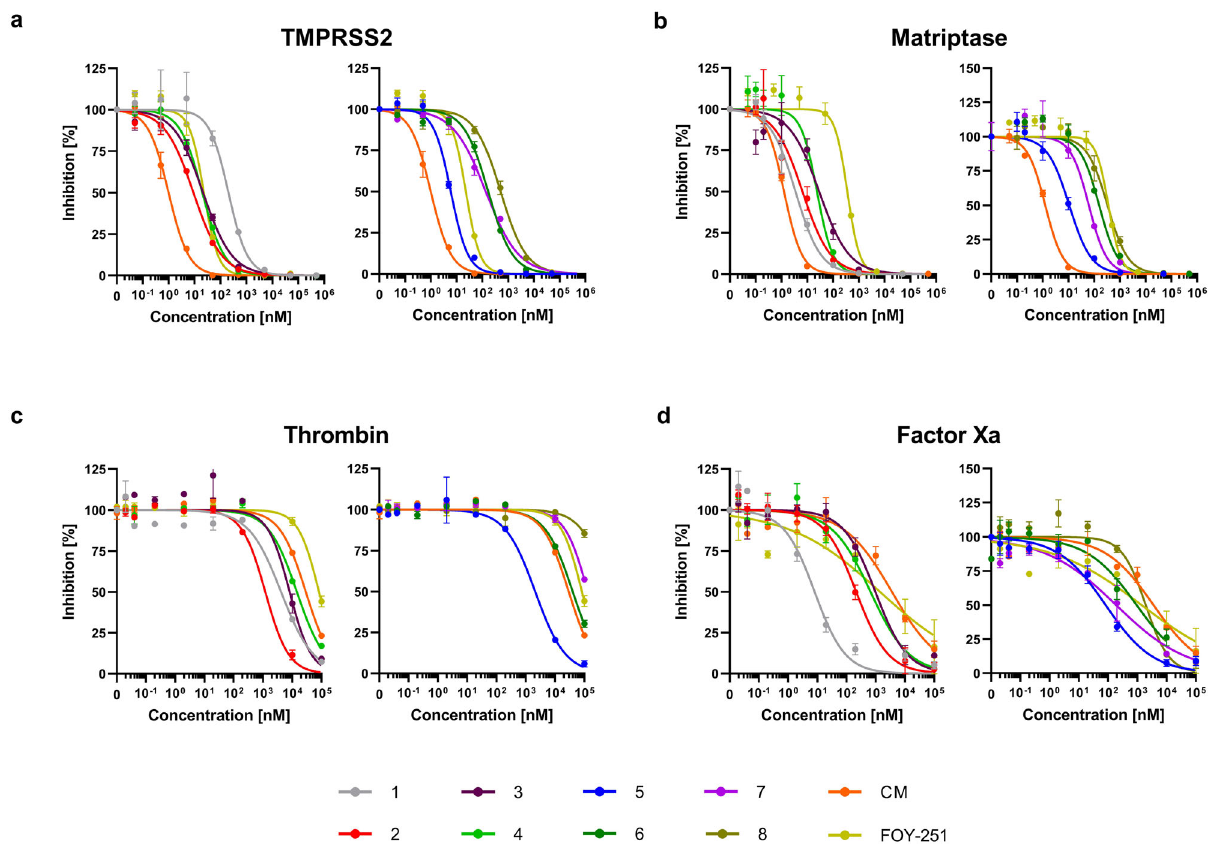
Fig. 2 Peptidomimetic inhibitors block activity of puri fi ed proteases. Isolated TMPRSS2 ( a ), matriptase ( b ), thrombin ( c ), and factor Xa ( d ) were mixed with peptidomimetic inhibitors, camostat mesylate (CM), and FOY-251. After 30 min, the fl uorogenic reference substrate Boc-Gln-Ala-Arg-AMC was added to TMPRSS2 or matriptase and the chromogenic substrates D -Phe-Homopro-Arg-pNA or Bz-Ile-Glu-Gly-Arg-pNA were added to thrombin or factor Xa, respectively. The velocity of substrate degradation was assessed by recording the fl uorescence intensity at 460 nm or the absorbance at 405 nm within 2 h. Shown are the means ± SD of n = 1 experiment performed in triplicates.